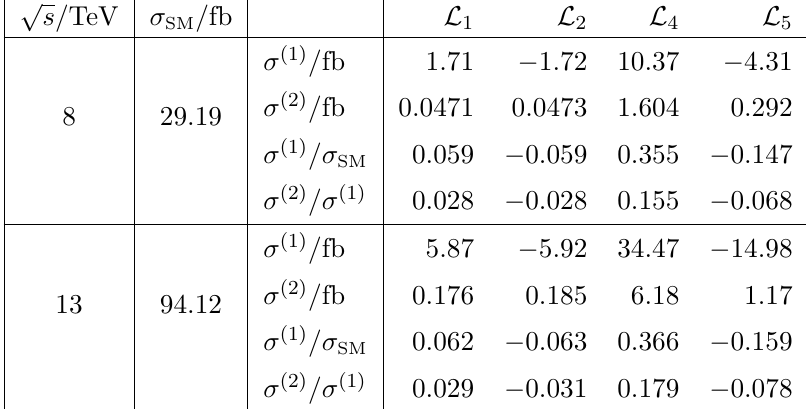
Table 21 . Cross sections for gg ! ZH production at the LHC at for the SM and the dimension-6 operators in analogy to ref.